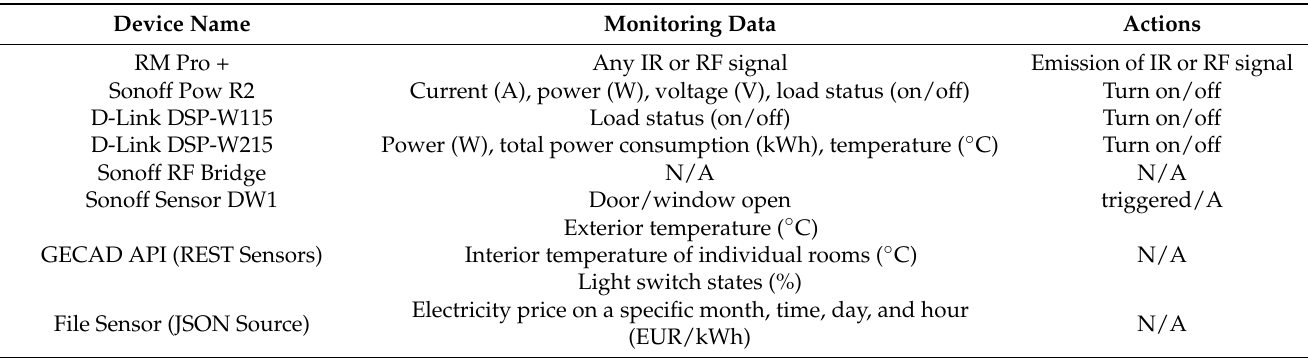
Table 1. Devices configured for the Home Assistant